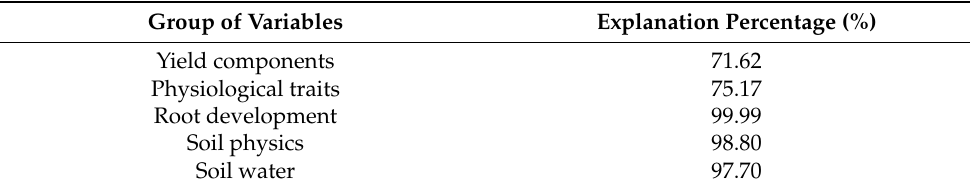
Table 1. Percentage explanation of the first major component of the variables yield components, physiological traits, root development, soil physics, and soil water.